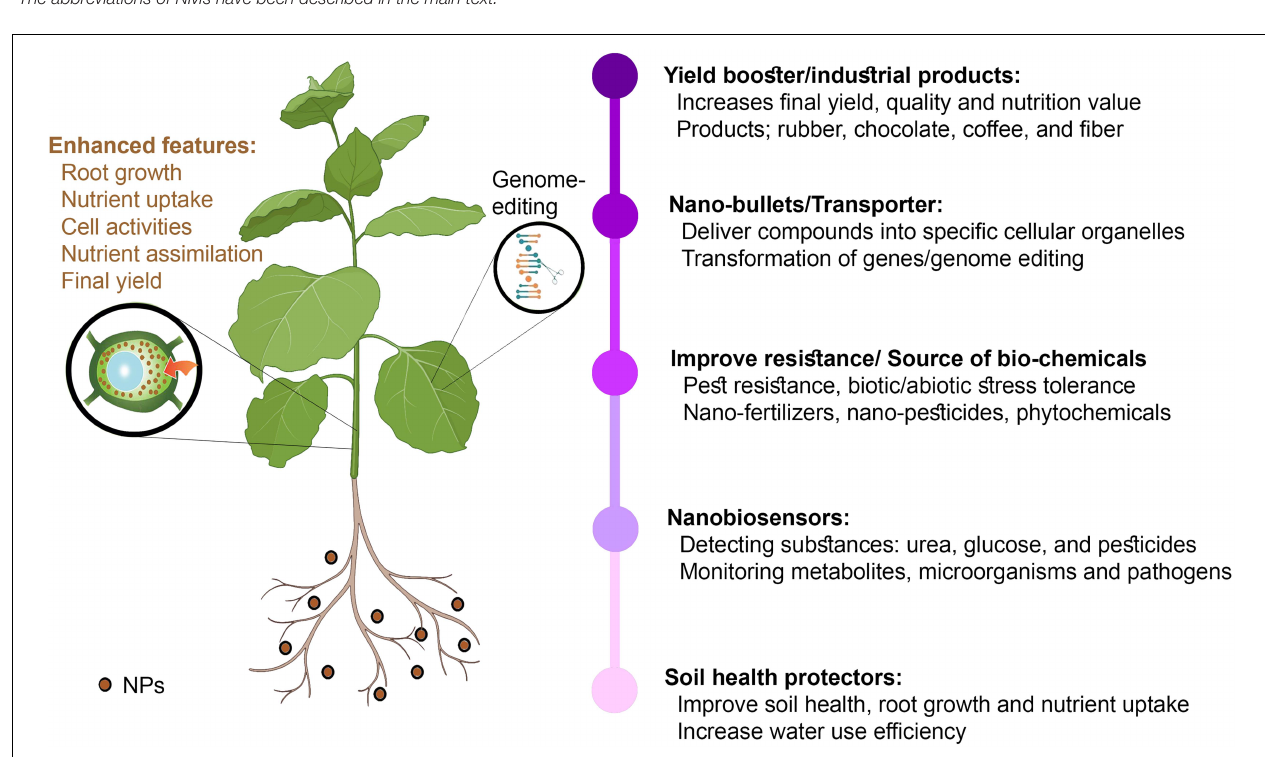
FIGURE 3 | Applications of nanotechnology in plant breeding and agricultural